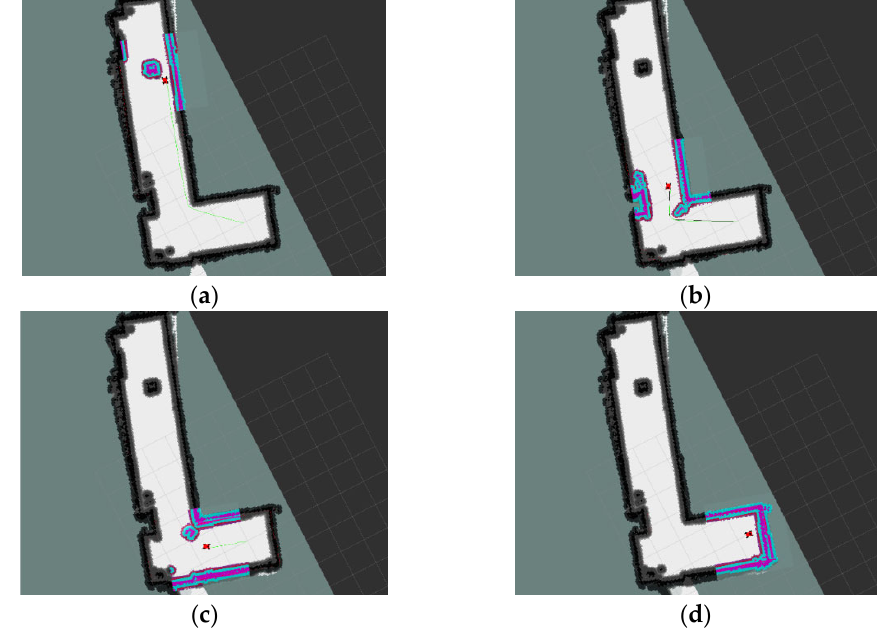
Figure 23. Navigation experiment in Rviz. ( a ) Start navigation; ( b ) Detect the obstacle; ( c ) Avoid the obstacle; ( d ) Reach the target point.